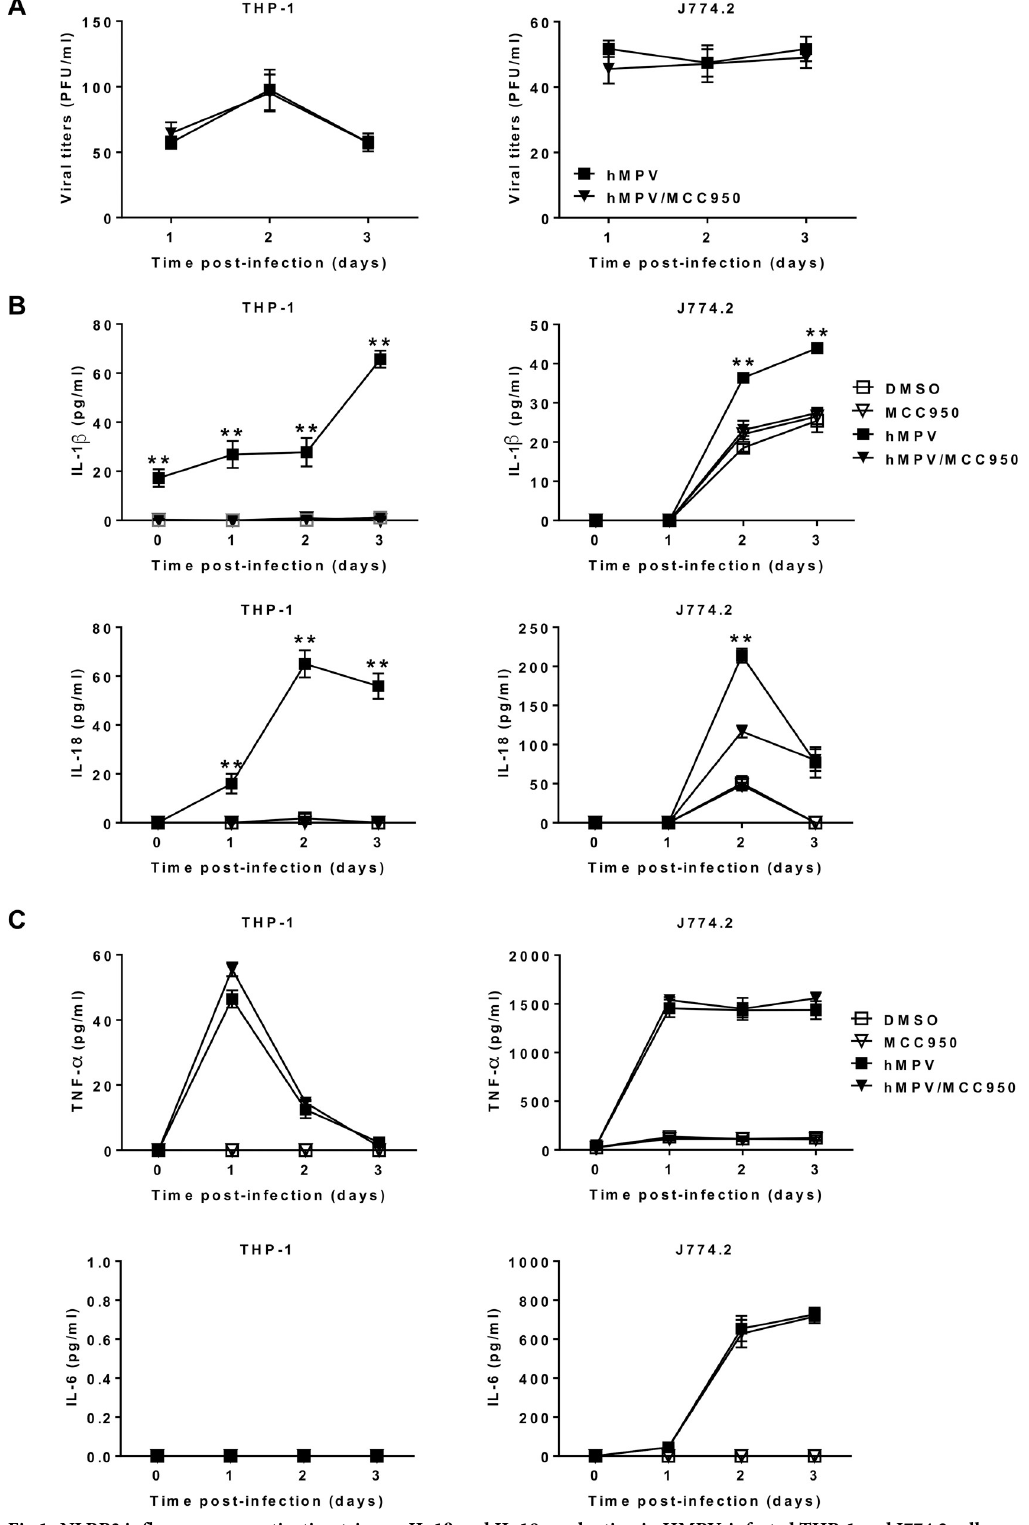
Fig 1. NLRP3 inflammasome activation triggers IL-1 β and IL-18 production in HMPV-infected THP-1 and J774.2 cells but has no effect on the viral replication. THP-1 cells were differenciated into macrophages using PMA (100 ng/ml). THP-1